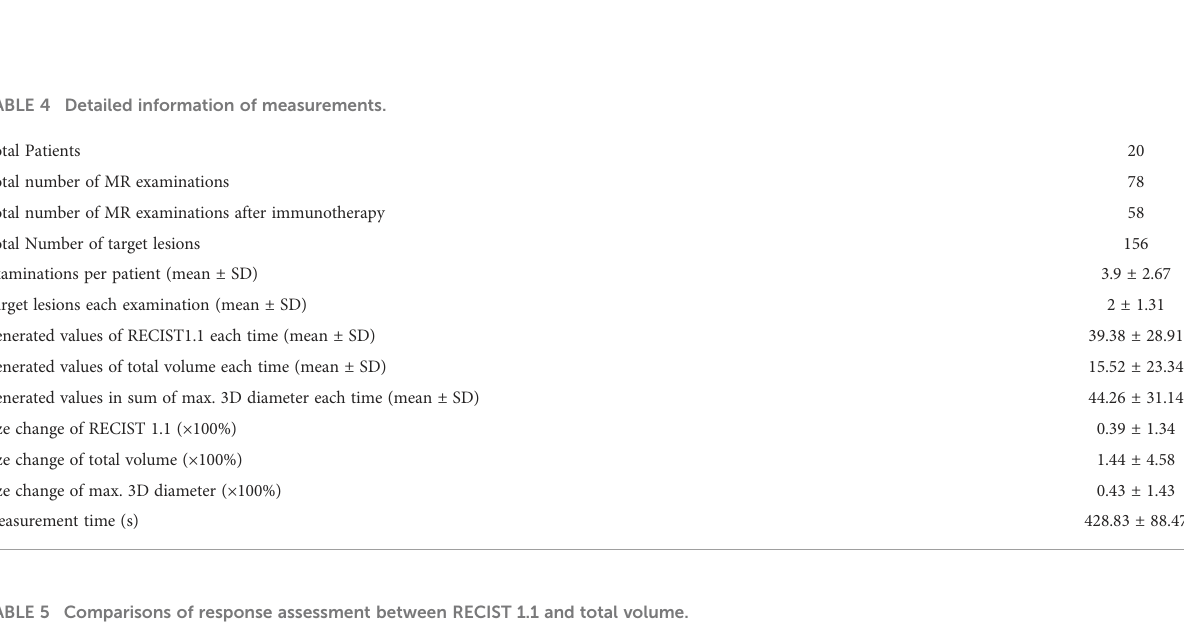
TABLE 5 Comparisons of response assessment between RECIST 1.1 and total